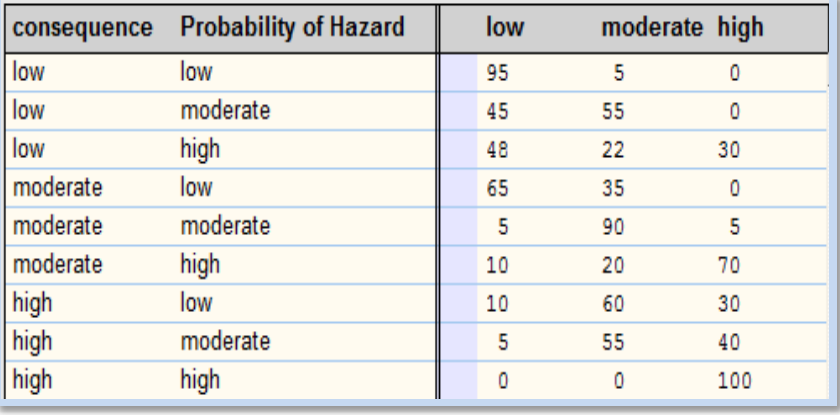
Figure 5. CPT for the risk level node considered in environmental risk assessment of SIWs.